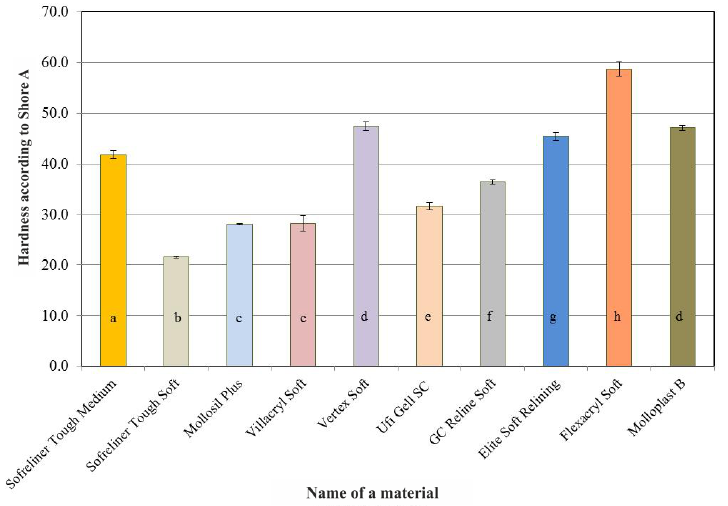
Figure 2. Average Shore A hardness values of the tested relining materials after seven days of conditioning the samples in distilled water. The same letters denote mean values which do not differ statistically significantly.